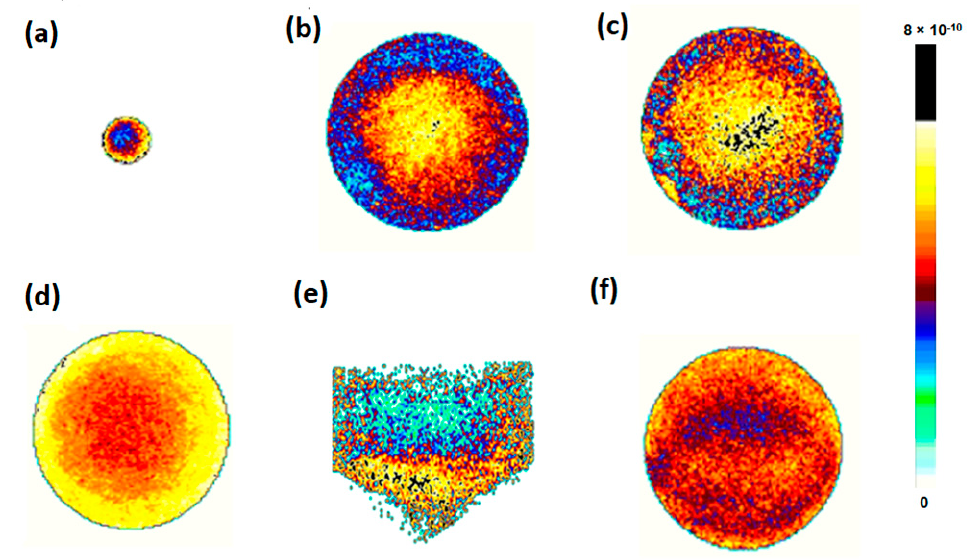
Figure 4. Diffusion experiments acquired using 300 MHz spectrometers equipped with MicWB40 Probe in combination with the Micro2.5 Gradient System. Diffusion maps of axial slices obtained on syringes containing each sample: ( a ) Somatuline Autogel ® , ( b ) AK1841045, ( c ) AK1841047, ( d ) AK1841050, and ( f ) AK1841053; diffusion maps of the sagittal slice of the syringe containing sam- ple ( e ) AK1841052. The color map on the right indicates D values (m 2 /s): yellowish color indicates a value closer to 8 × 10 − 10 , while blueish color indicates a value closer to